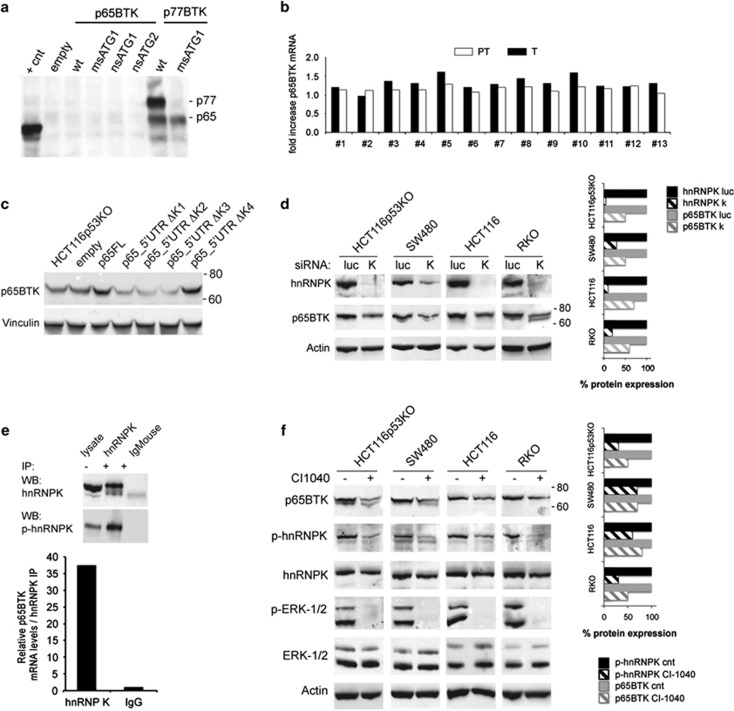
hnRNPK and active ERKs post-transcriptionally regulate p65BTK expression. (a) In vitro translation assay performed with the following plasmids: empty vector (empty); p65FL (wt), p65_msATG1, p65_nsATG1, p65_nsATG2, p77_5′UTR or p77_msATG1. +cnt indicates the positive control included in the commercial kit used for the reaction. (b) p65BTK mRNA expression in matched samples of tumoural and peritumoural colon tissue from CRC patients (same patients as in Figure 1b). mRNA was quantified by Taqman assay and expression levels normalized to phosphoglycerate kinase. (c) Western blot of 293T cells transfected with empty vector (empty) or the following plasmids: p65FL, p65_5′UTRΔK1, p65_5′UTRΔK2, p65_5′UTRΔK3, p65_5′UTRΔK4. Deletion of all four binding sites allowed p65BTK overexpression most likely by rendering the transcript as it would be a CDS. (d) Western blot of p65BTK levels in colon cancer cell lines after siRNA-mediated depletion of hnRNPK (K). Transfection with siRNAs targeting luciferase (luc) was used as a control. On the right, the percentage of hnRNPK and p65BTK protein expression of each sample as calculated and normalized to actin by ImageJ program (http://imagej.nih.gov/ij/). (e, top) Anti-hnRNPK and anti-phospho-hnRNPK western blots after RNA immunoprecipitation using anti-hnRNPK and isotype-matched control (Ig mouse) antibodies. (e, bottom) Real-time PCR of p65BTK mRNA recovered by RIP in hnRNPK and IgG immunoprecipitates. (f) Western blot of p65BTK expression and hnRNPK-Ser284 phosphorylation following ERK1/2 inhibition with the MEK1/2 inhibitor CI-1040 (10 μM). Levels of total and phospho-ERKs are also shown. Cell lysates were obtained 24 h after CI-1040 addition but for HCT116p53KO cells, where p65BTK reduction is most prominent, at 16 h. On the right, the percentage of p-hnRNPK and p65BTK protein expression of each sample was calculated and normalized to actin by ImageJ program.